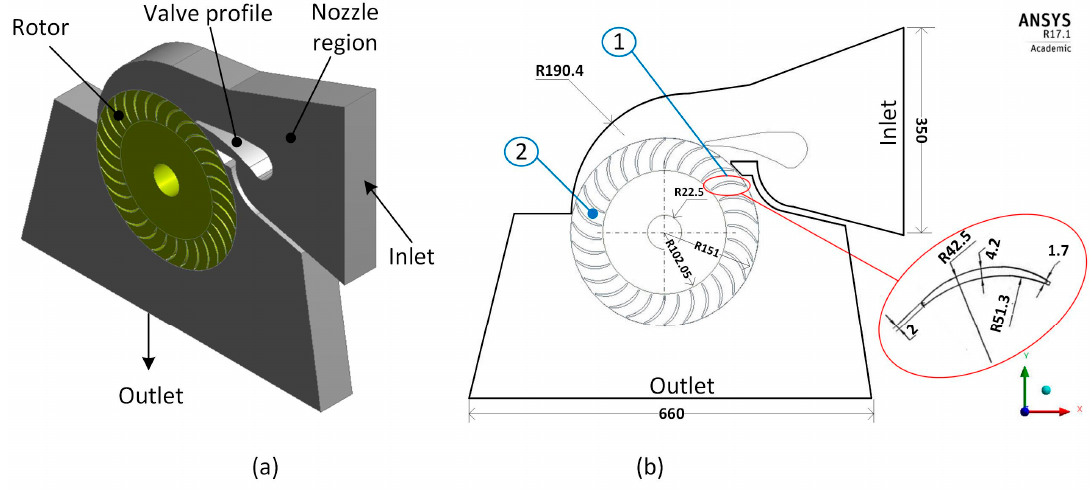
Figure 4. T15-300 cross-flow turbine design: ( a ) 3D geometry, ( b ) front view with detailed blade geometry.